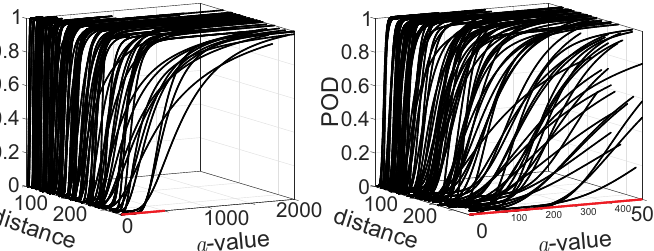
Figure 13. POD curves for all non-horizontal paths, which all cross the stringer over the distance. The right figure shows a detail of the left zooming in to a -values from 0mm 2 to 500mm 2 . To analyze the effect on the a values, the extracted values for all paths crossing 90 | 95 the stringer are plotted over the absolute distance from the flaw to the path. The data are shown in a semilogarithmic scale in Figure 14. This way, a good representation of the influence of distance on the a values is given. With the chosen scale, the variation of 90 | 95 data is approximately constant over the whole range of distances. For the absolute values, this emphazises the effect of increasing variance with increasing absolute distance